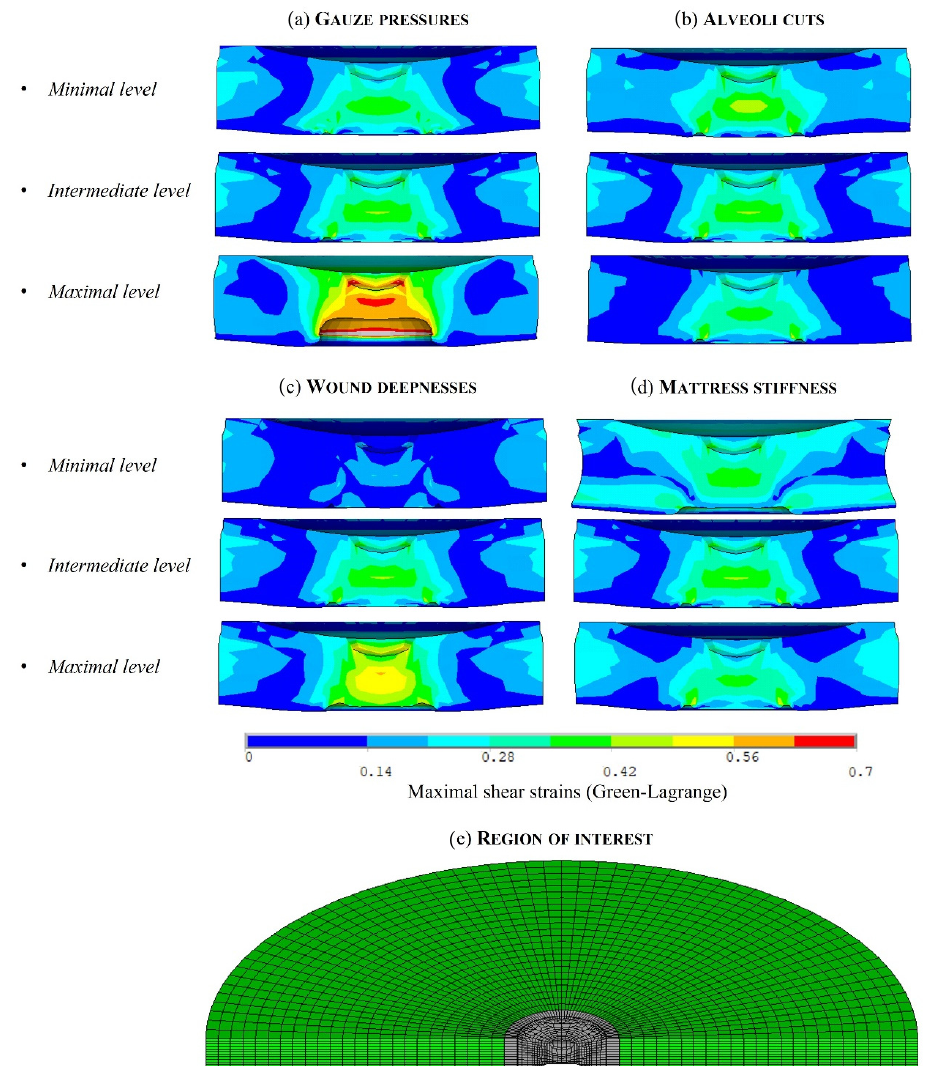
Figure 5. Green–Lagrange maximal shear strains in the ROI of some experiments. All parameters were set to the intermediate values except for one that varied according to the defined levels: ( a ) changes in the gauze pressure, ( b ) changes in the alveoli cut, ( c ) changes in the wound deepness, and ( d ) changes in the mattress stiffness. The ROI appears in grey in ( e ).